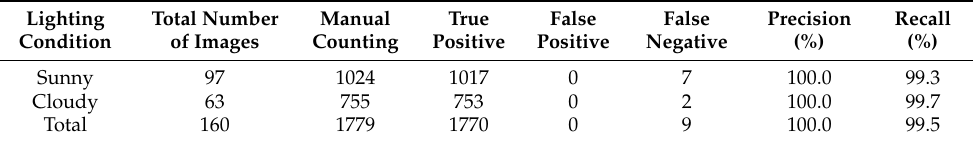
Table 6. The detection results of images taken under different lighting conditions.